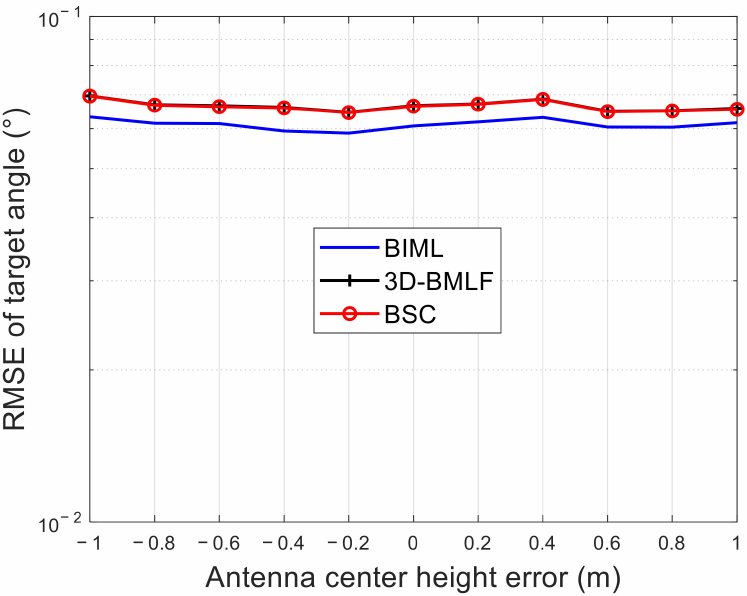
Figure 9. The RMSEs of the target angle for the three algorithms against the antenna center height